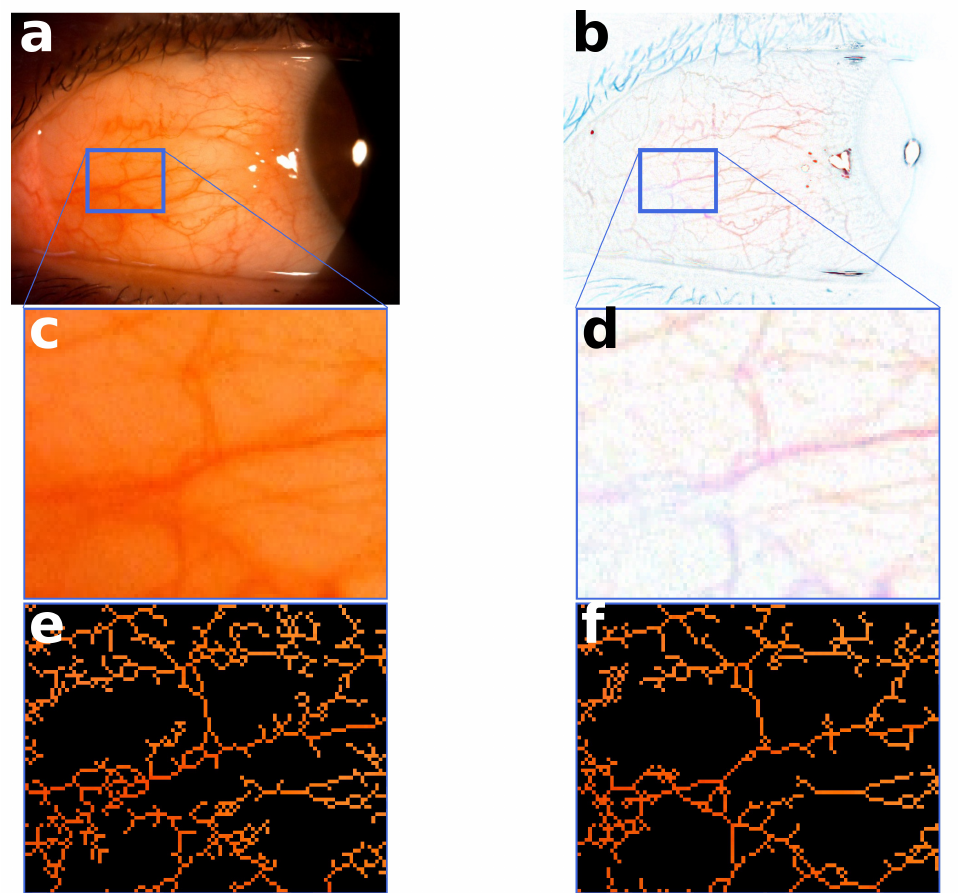
Figure 3. Comparison between the raw image and the result of our standardization algorithm. ( a , c ) the original image and corresponding enlarged area. In this case, the image acquisition was performed with an incorrect light exposition, which leads to an unbalanced redness component along the entire conjunctiva area. It is evident in the enlarged section how the vessel color tends to be very close to the background, making it their evaluation difficult and creating a false positive redness component in the conjunctiva. ( b , d ) the standardized image and corresponding enlarged area. The standardization algorithm allows for better discriminating the vessels network component from the red-like background. In the enlarged portion, we can see how the algorithm is able to split the vessels with the uniform background, despite the latter having a non-negligible redness component; ( e ) the vessels network segmentation estimated on the raw image; ( f ) the vessels network segmentation estimated on the standardized image. The standardization processing allows for removing the artifacts (false positive branches) related to the red-like background